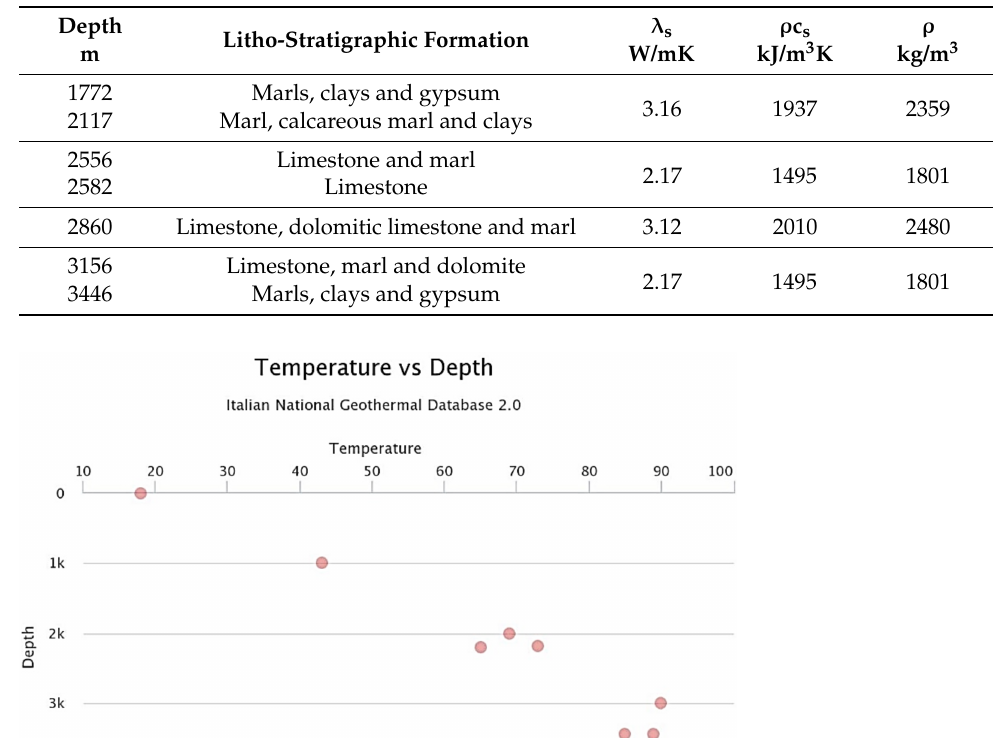
Table 3. Gela 38 hydrocarbon well-lithostratigraphic profile (Gela Field, Sicily).